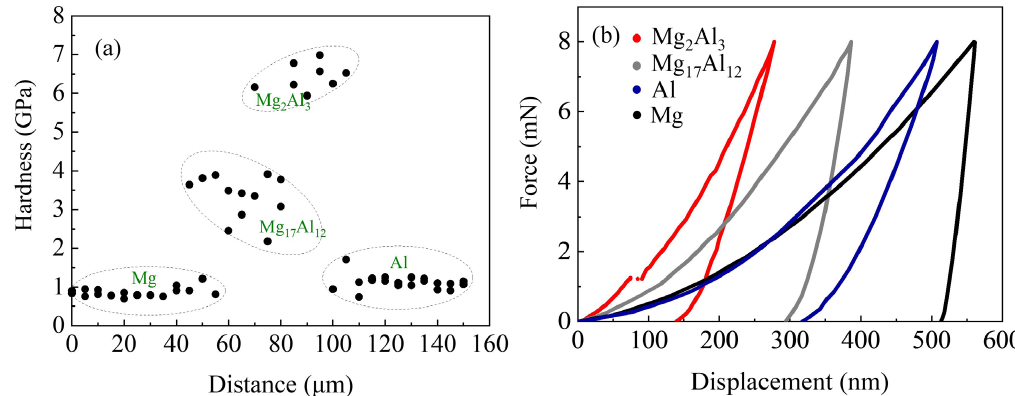
Figure 8. Nanoindentation results for welded joint (a) Hardness distribution (b) P-h curves.